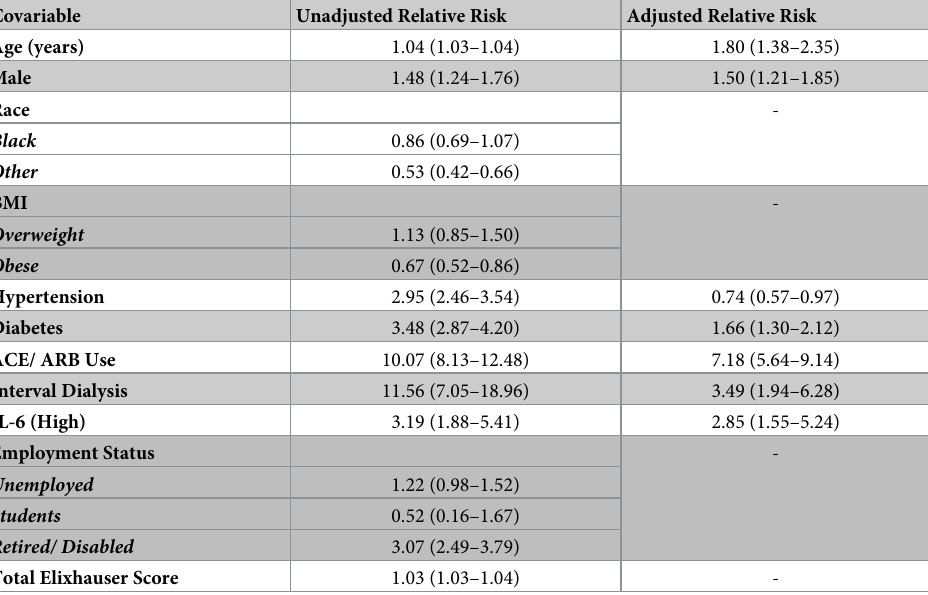
Table 3. Logistic regression showing association between covariables and severe COVID-19